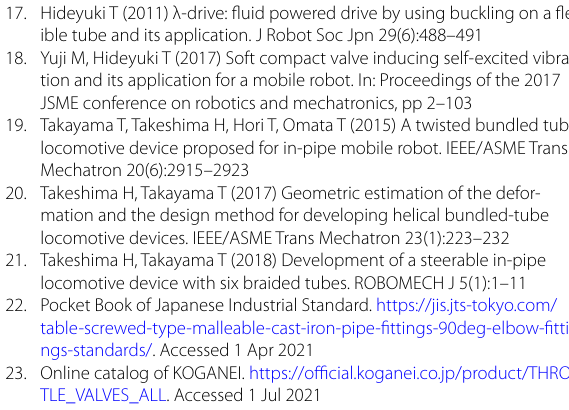
table- screw ed- type- malle able- cast- iron- pipe- fitti ngs- 90deg- elbow- fitti ngs- stand ards/. Accessed 1 Apr